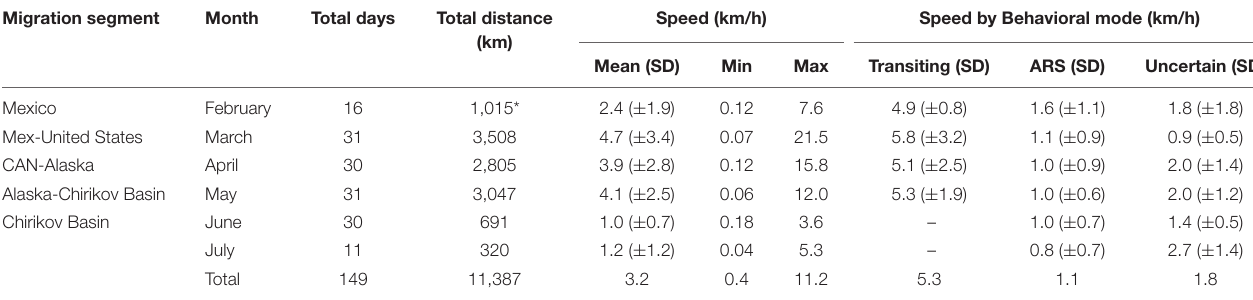
TABLE 1 | Summary of the obtained data by the satellite transmitter placed on María from San José del Cabo, BCS, Mexico, to the Chirikov Basin, 2017. Migration segment